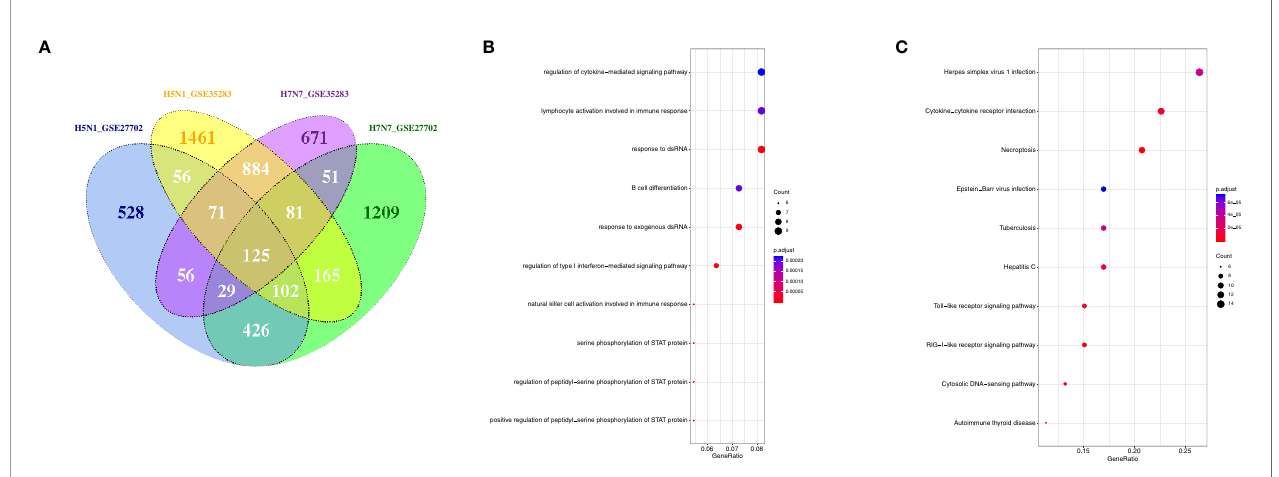
FIGURE 8 | The overlapped regulation gene expression of monocytes and macrophages in response to avian in fl uenza virus infection. (A) A Venn diagram of the overlap genes between H5N1 and H7N7-infected monocytes and monocyte-derived macrophages; (B) GO biological processes of differentially expressed overlap. The vertical axis shows the functional classi fi cation, and the horizontal axis shows the GeneRatio; (C) KEGG pathways of differentially expressed overlap genes. The vertical axis shows the number of genes, and the horizontal axis shows the